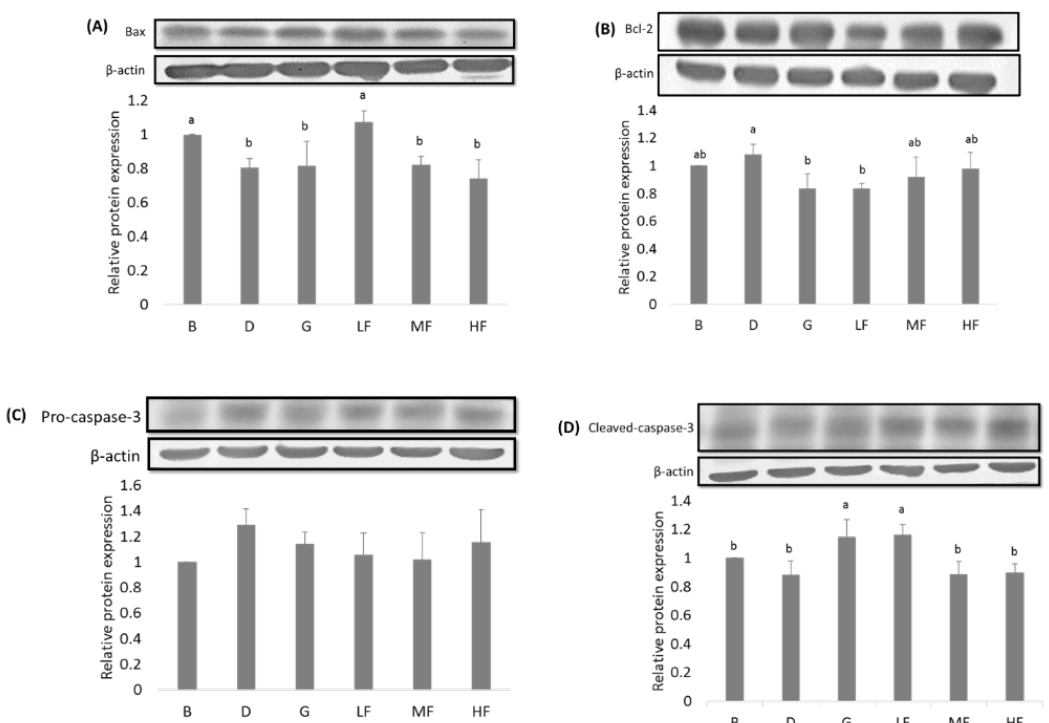
Figure 3. E ff ects of GBR and FGBR on the colonic expressions of ( A ) Bax (20 KDa), ( B ) Bcl-2 (26 KDa), ( C ) pro-caspase-3 (32 KDa) and ( D ) cleaved caspase-3 (16 KDa) in F344 rats. The bars represent the mean ± SD ( n = 3). Values with the same letter are not significantly di ff erent from one another as determined by Duncan’s multiple range test, p < 0.05. All rats except those in group B were administered with DMH / DSS. B (blank) and D (control): AIN-93G diet; G: AIN-93G containing 10% GBR; LF: AIN-93G containing a low dose (2.5%) of FGBR; MF: AIN-93G containing a medium dose (5%) of FGBR; HF: AIN-93G containing a high dose (10%) of FGBR.